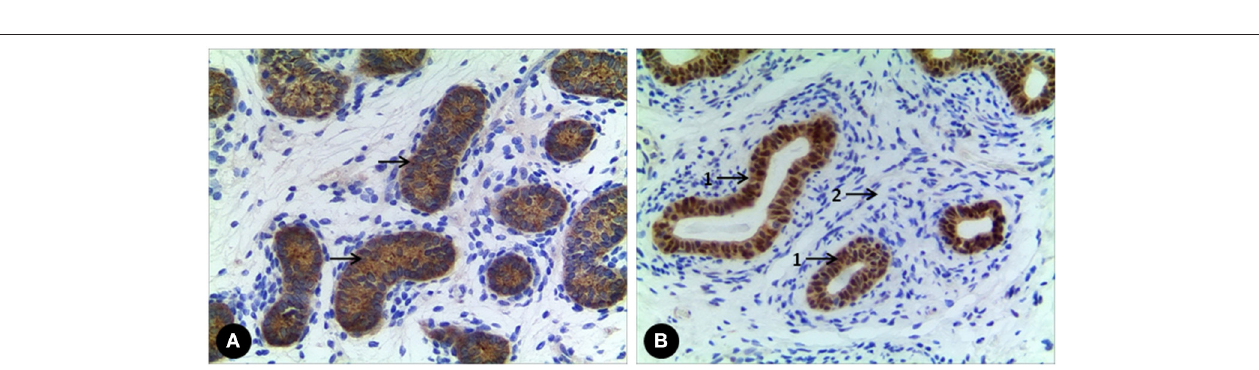
FIGURE 2 | (A) A 52 month-old vanishing testis patient. The GCs (arrow) are easily identified in H&E stain, (B) while the GCs (arrow) are negative to Oct3/4. (C) A 17 month-old vanishing testis patient showing the GCs (arrow) with nuclear positive for Oct3/4. (D) Another 28 month-old vanishing testis patient showing the GCs (arrow) with nuclear positive for Sall4. Images under × 200 visual field.